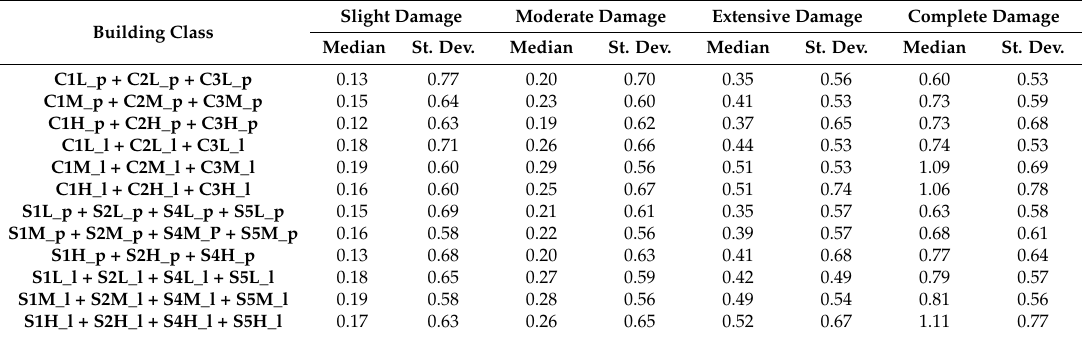
Table A3. Median and standard deviation for simplified reinforced concrete (C) and simplified steel buildings (S) for medium strong motion duration (5.5 < M ≤ 7.5).